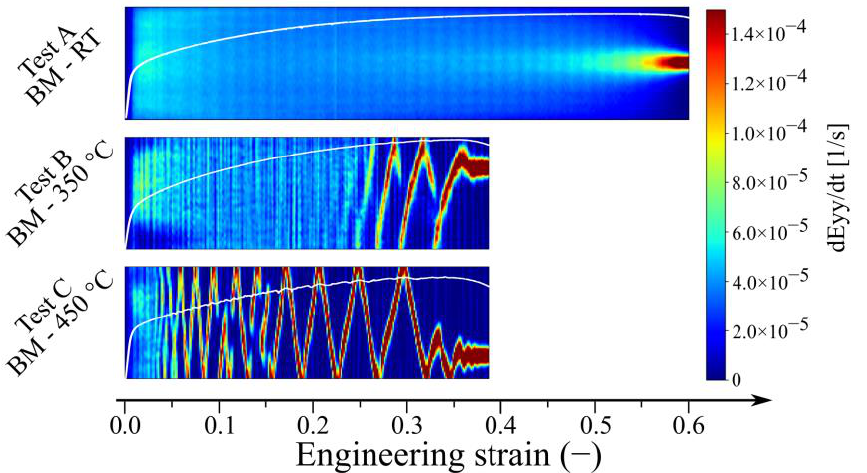
Figure 4. Strain rate maps of tests performed on base material at RT (Test A), at 350 °C (Test B), and at 450 °C (Test C). The engineering stress – strain curves of each test are overlaid on the strain rate maps in white.